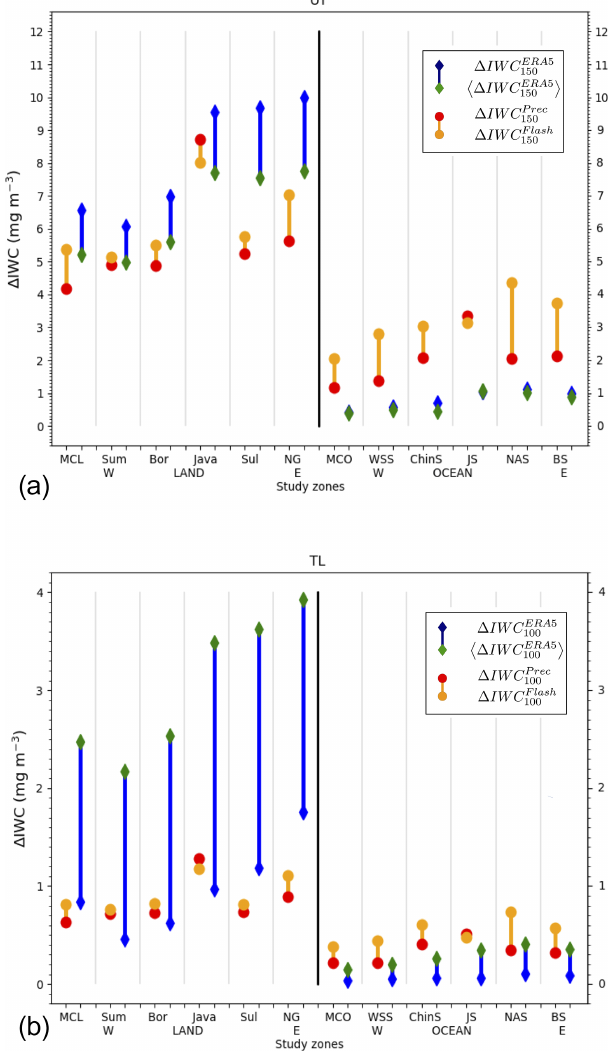
Figure 11. (a) (cid:49) IWC (mg m − 3 ) estimated from Prec (red) and Flash (orange) at 146hPa and (cid:49) IWC estimated from ERA5 at the level 150hPa and at the level 150hPa degraded in the vertical, over islands and seas of the MariCont: MariCont_L (MCL) and Mari- Cont_O (MCO); from west (W) to east (E) over land, Sumatra (Sum), Borneo (Bor), Java, Sulawesi (Sul) and New Guinea (NG); and over seas, West Sumatra Sea (WSS), China Sea (ChinS), Java Sea (JS), North Australia Sea (NAS) and Bismarck Sea (BS). (b) Same as in (a) but for